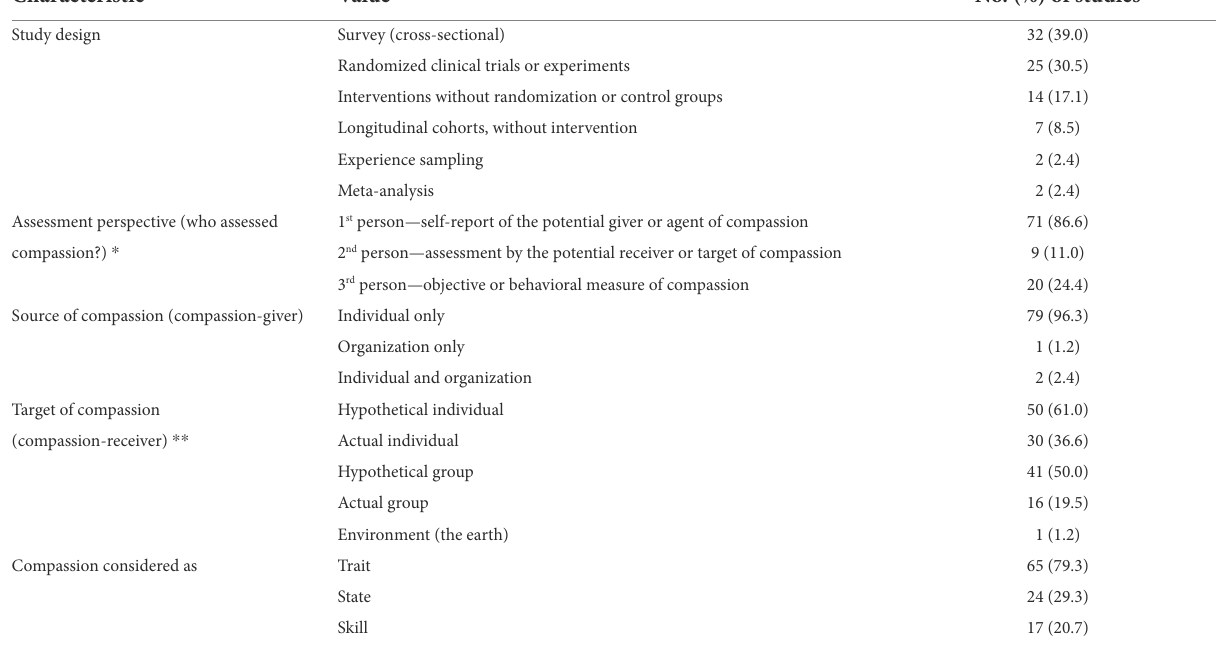
TABLE 1 Characteristics of 82 studies included in the analysis of risk factors for compassion.